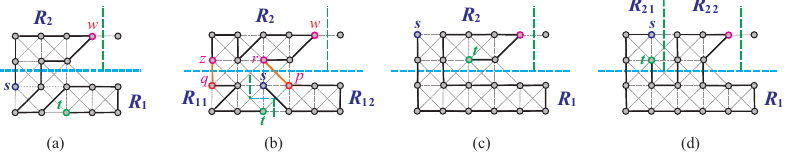
Figure 27. A longest ( s , t ) -path in C ( m , n ; k , l ; c , d ) when (UB12) holds, where ( a , b ) s , t ∈ R 1 , and ( c , d ) s , t ∈ R 2